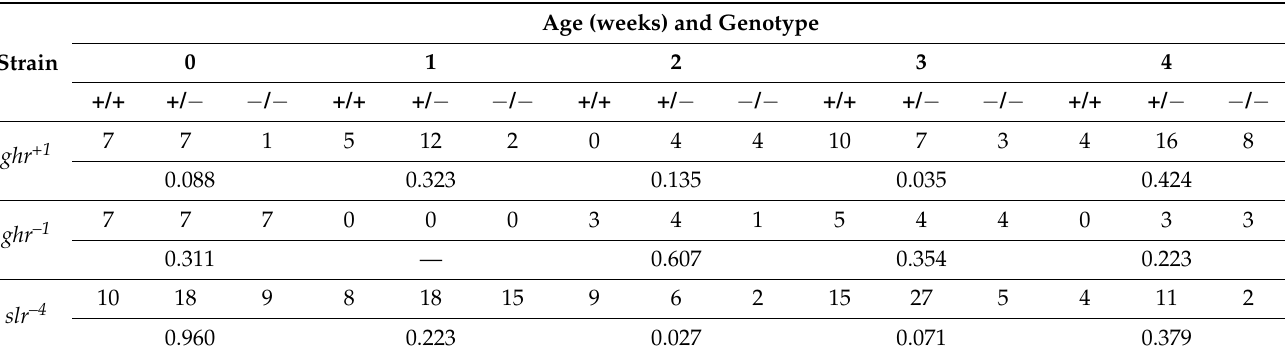
Table 5. Viability of ghr +1 , ghr − 1 , and slr − 4 F 2 larval fish according to genotype. Age (weeks) and